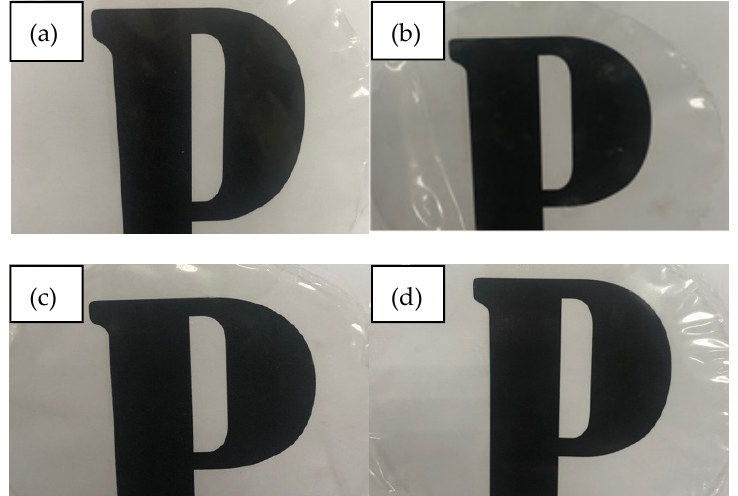
Figure 2. Physical appearance of starch/CNF bionanocomposite films incorporated with ( a ) 0, ( b ) 3, ( c ) 5, and ( d ) 10 wt.% of thymol.